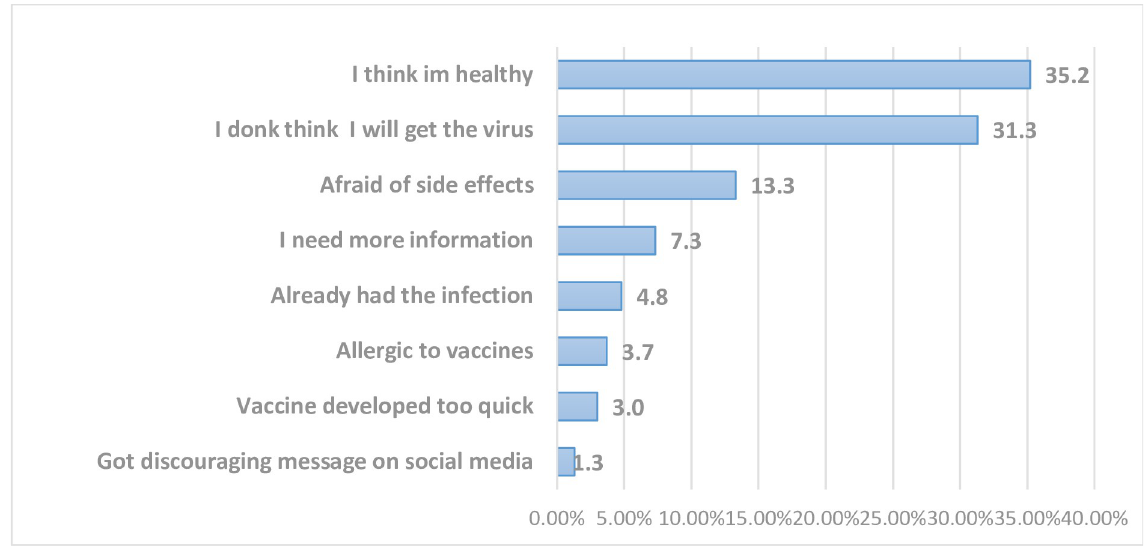
Fig 3. Respondents’ reasons for not willing to accept COVID 19